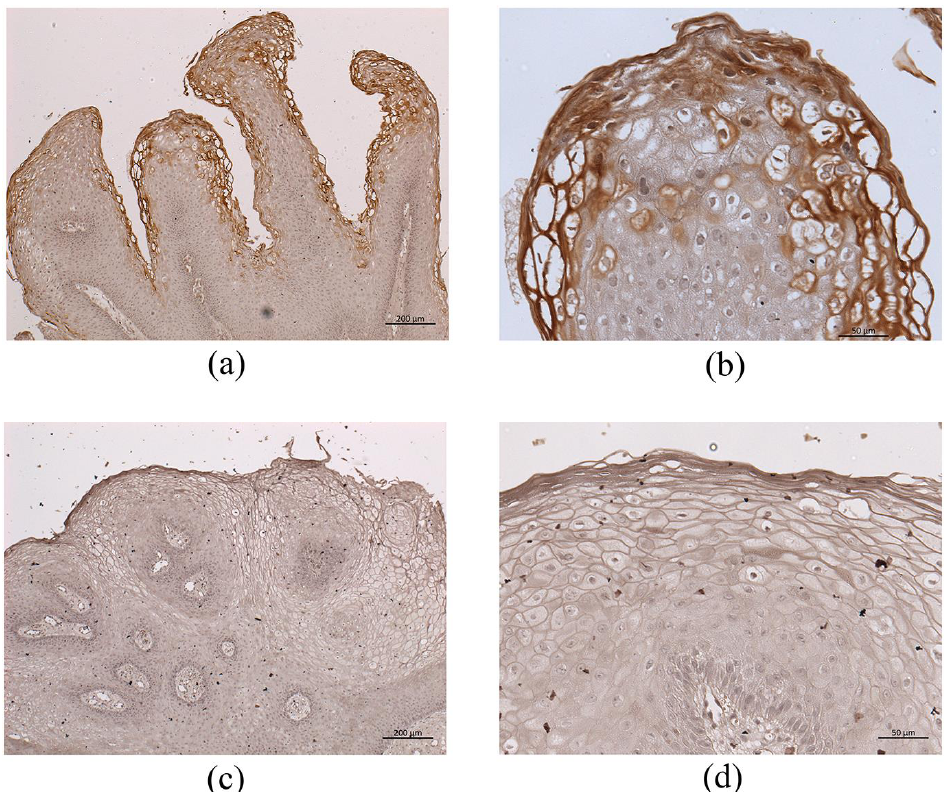
Figure 7. Immunohistochemistry for HPV-6 E4 in HPV-6-infected ( a and b ) and HPV-11-infected (c and d) LP. ( a ) Immunohistochemistry for HPV-6 E4 (low magnification) in HPV-6-infected LP (bar = 200 μm). ( b ) Immunohistochemistry for HPV-6 E4 (high magnification) in HPV-6-infected LP (bar = 50 μm). ( c ) Immunohistochemistry for HPV-6 E4 (low magnification) in HPV-11-infected LP (bar = 200 μm). ( d ) Immunohistochemistry for HPV-6 E4 (low high magnification) in HPV-11- infected LP (bar = 50 μm). Strong immunoreactivity was observed in ( a ) and ( b ), but there were no positive reactions in ( c ) and ( d ).